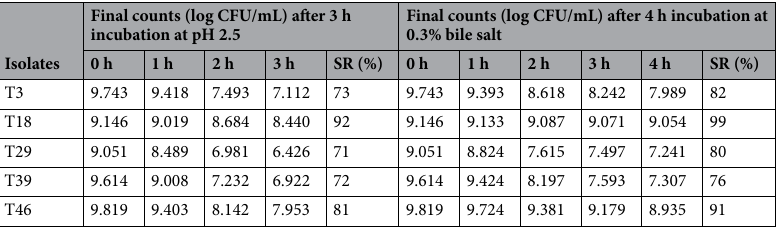
Table 1. Re-screening results and survival rates (%) of selected LAB after 3 h incubation at pH 2.5 and 4 h incubation at 0.3% bile salt. SR Survival rate.